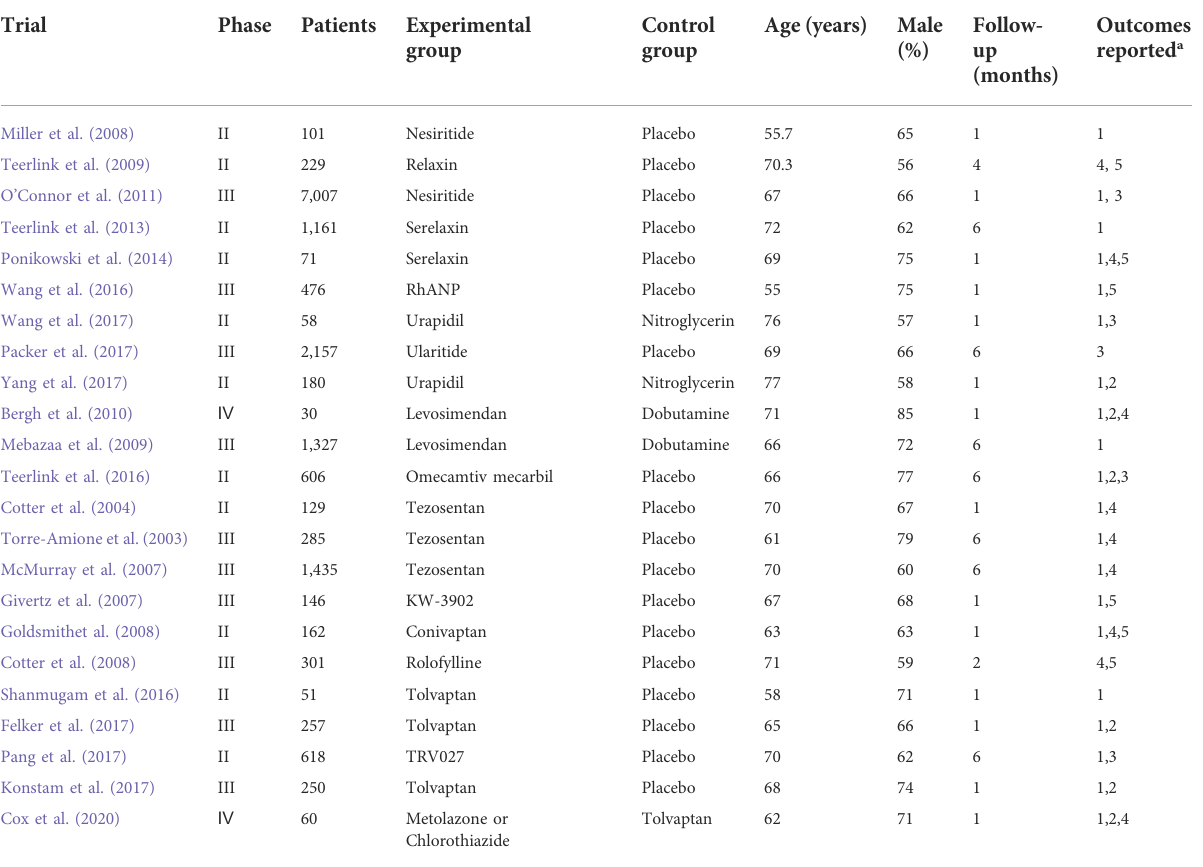
TABLE 1 Key features of the included studies.